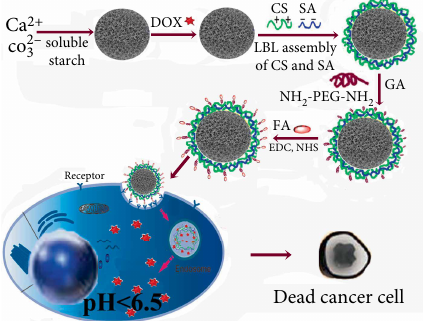
Figure 1: Molecular targeting and drug controlled release of nanoparticles assembled layer by mesoporous CaCO 3